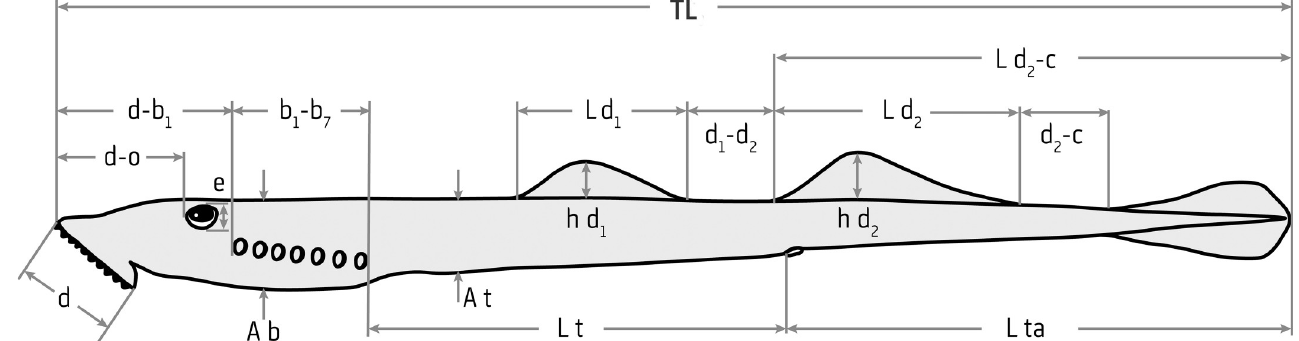
Fig 2. Lateral view of an adult lamprey depicting morphometric measurements. d: oral disc length; d-o: snout to eye length; d–b 1 : prebranchial length; b 1 -b 7 : branchial length; e: eye height; Ab: maximum branchial depth; At: maximum trunk depth; Lt: trunk length; Lta: tail length; Ld 1 : length of first dorsal fin; hd 1 : height of first dorsal fin; d 1 -d 2 : space between dorsal fins; Ld 2 : length of second dorsal fin; hd 2 : height of second dorsal fin; d 2 -c: space between the posterior end of the second dorsal fin and origin of caudal fin; Ld 2 -c: length from origin of the second dorsal fin to the tip of the caudal fin; TL: total length. Not shown is oral disc width